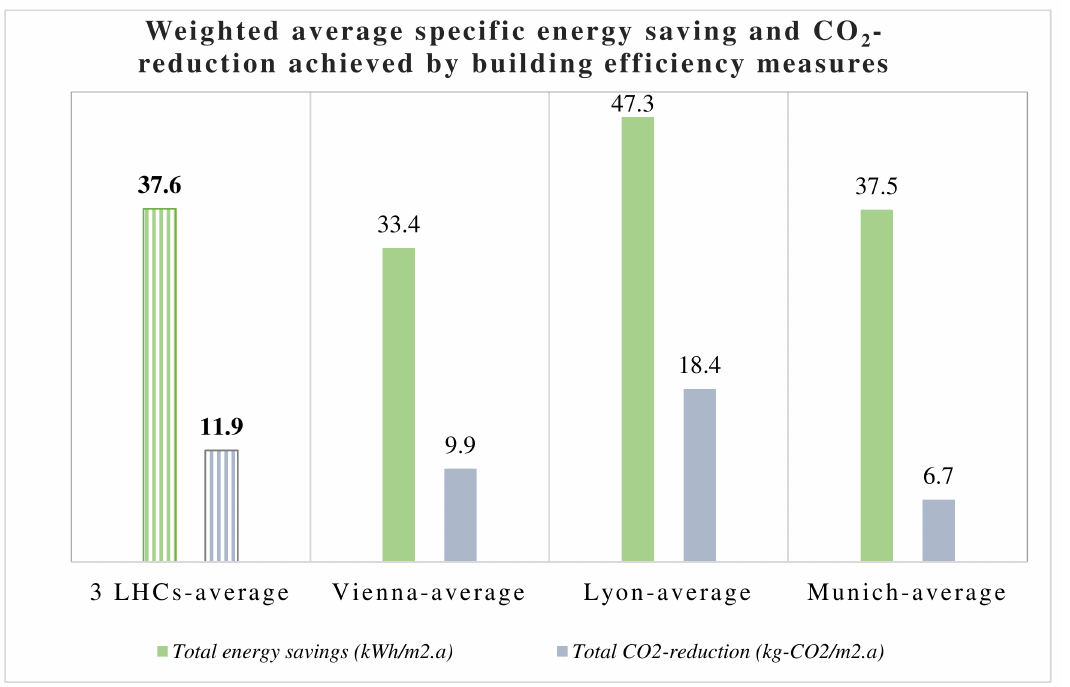
Figure 14. Specific final energy saving, and CO 2 emission reduction determined as weighted average value over the whole refurbished floor area (for each LHC as well as all